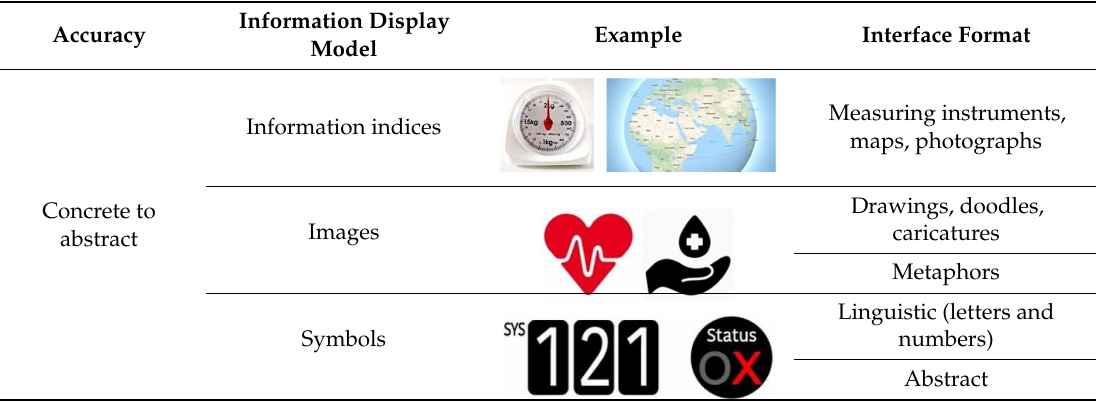
Table 1. Information display dimensions and